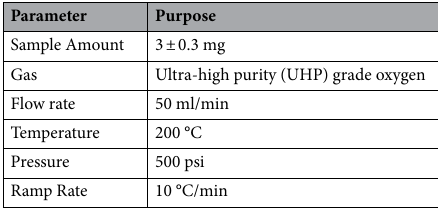
Table 5. Operating condition for P-DSC.